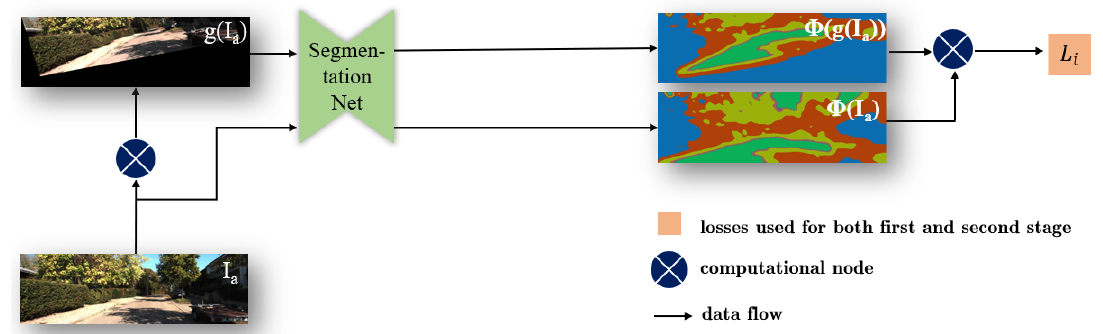
Figure 2. The original image I a undergoes a random transform to generate g ( I a ) . Both of them are then passed separately into the segmentation net, and yield the probability feature map Φ ( g ( I a )) and Φ ( I a ) to calculate the mutual information loss L i